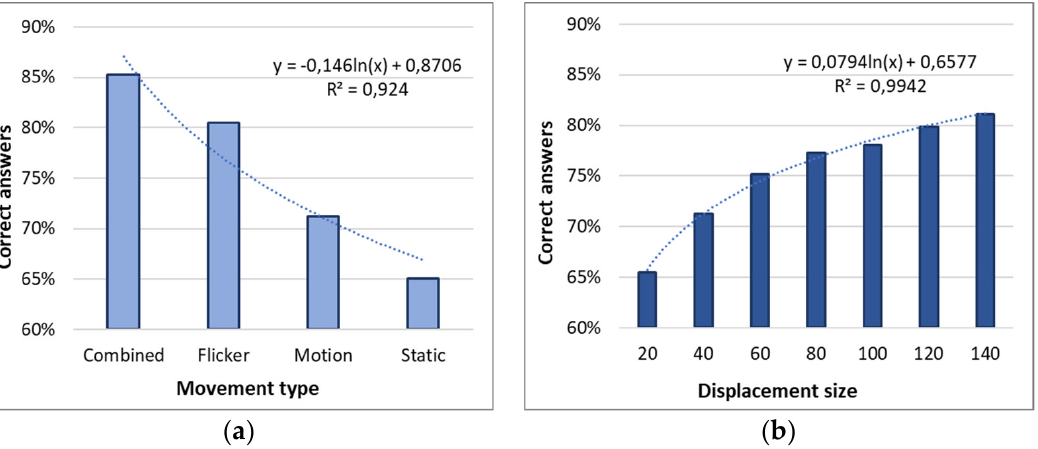
Figure 11. ( a ) Influence of the type of movement of the stimuli on the number (percentage) of correctly solved visual tasks by all participants in the experiment. ( b ) Influence of the size of displacement from the center of the set of dots on the number (percentage) of correctly solved visual tasks by all participants in the experiment.